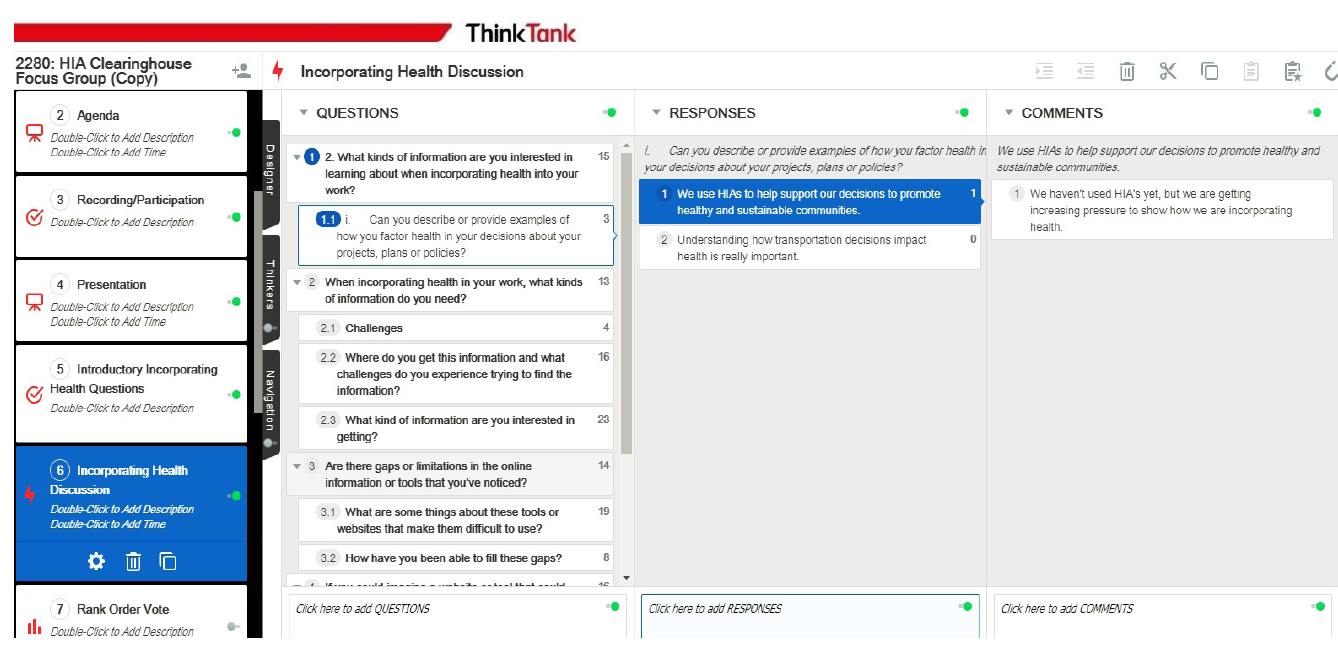
Figure 1. Screenshot of an Example ThinkTank